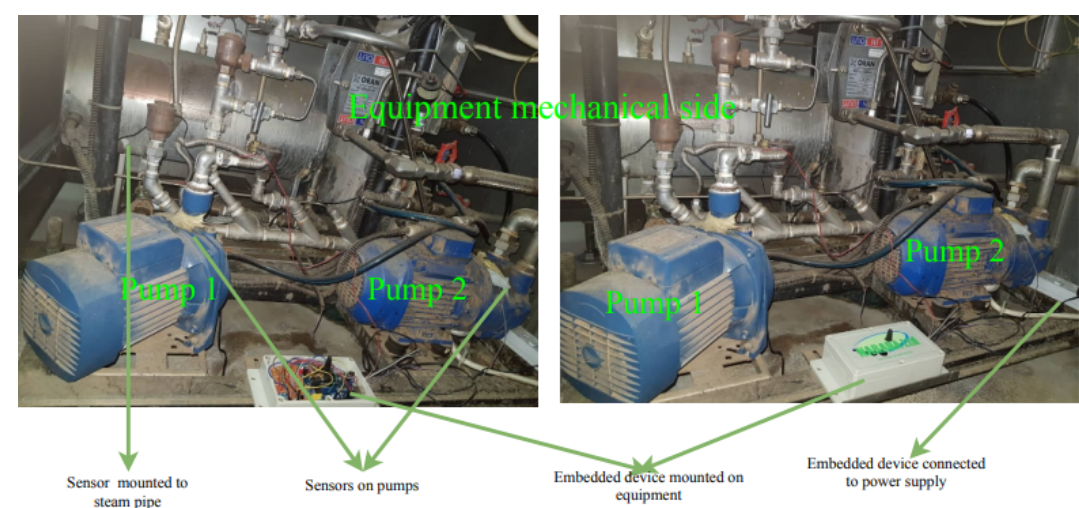
Figure 7. Developed data collector connected on equipment’s